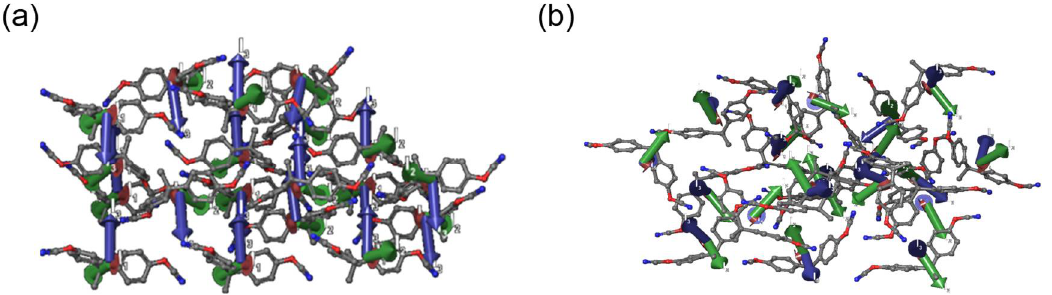
Figure 6. Snapshots of ( a ) BADCy and ( b ) LECy, highlighting the ordering of close contacts. The principal moments of inertia are displayed as a set of orthogonal tubes.